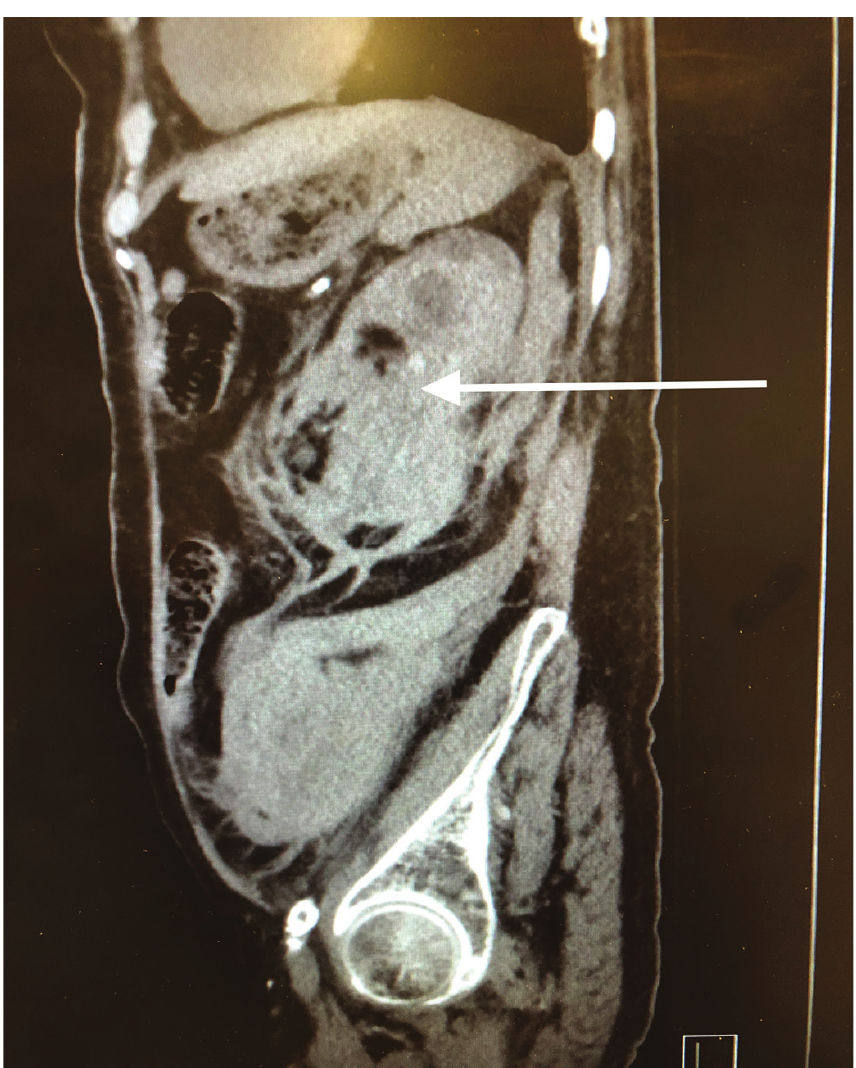
Figure 2: Sagital CT image of left retroperitoneal hemorrhage. The arrow shows the extensive left retroperitoneal hematoma with rupture of the left